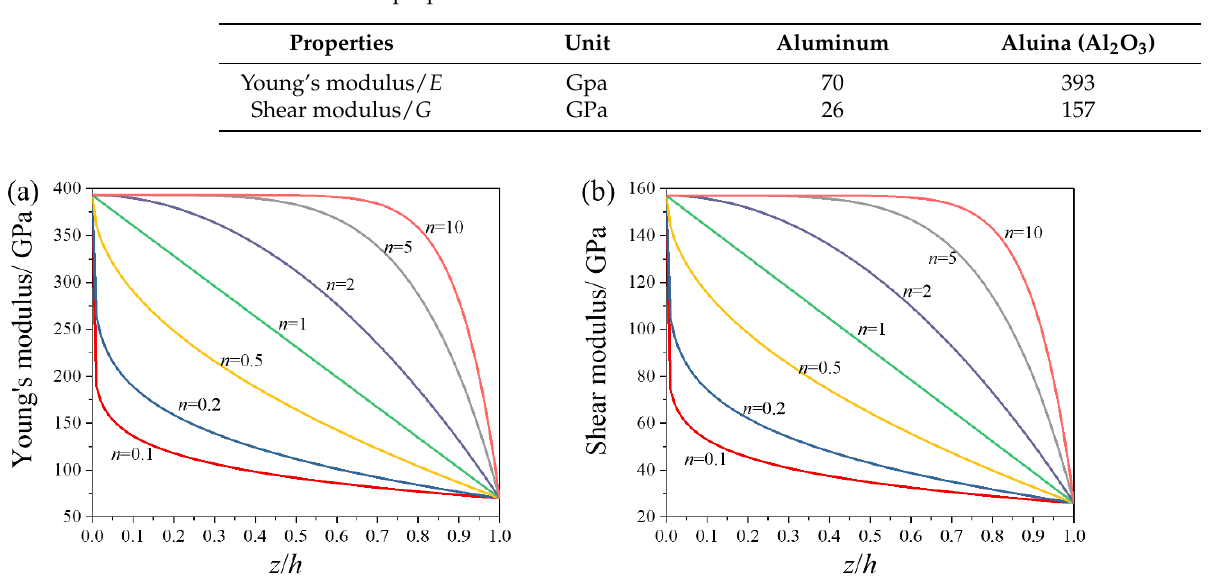
Figure 2. Material properties through the thickness with the profile parameter n : ( a ) Young’s modulus; ( b ) shear modulus.